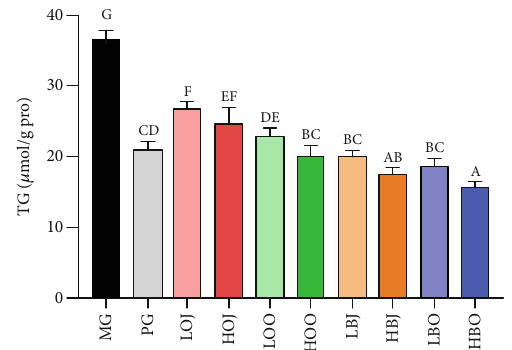
Figure 3: E ff ect of di ff erent treatments on the level of TG. Values are expressed as the mean ± SD ( n = 8 ). Data with di ff erent letters indicate signi fi cant di ff erences ( P < 0 : 05